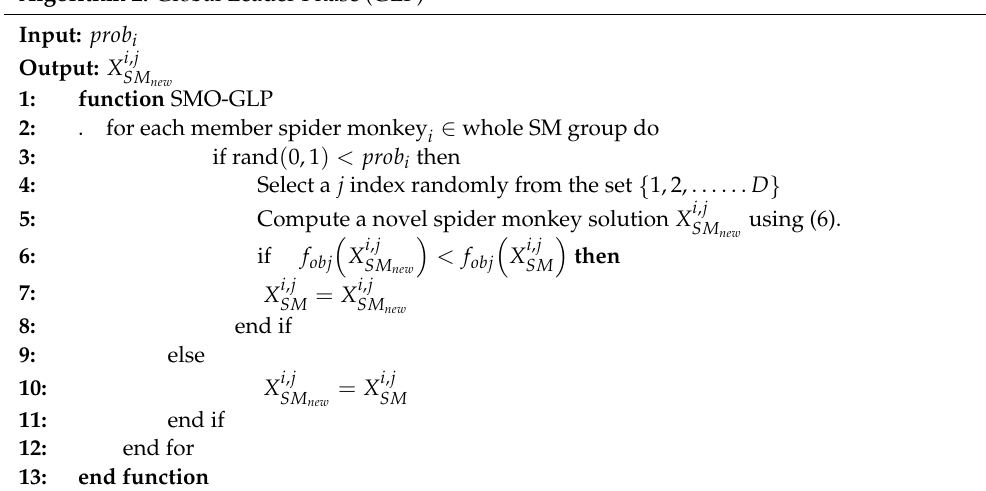
Algorithm 2: Global Leader Phase